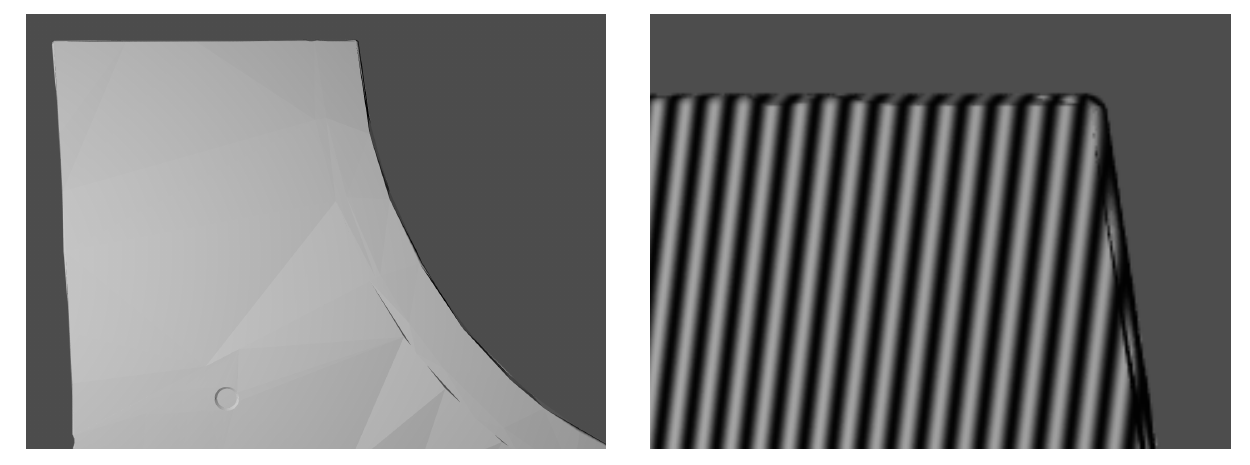
Figure 8. Enlarged view of phase